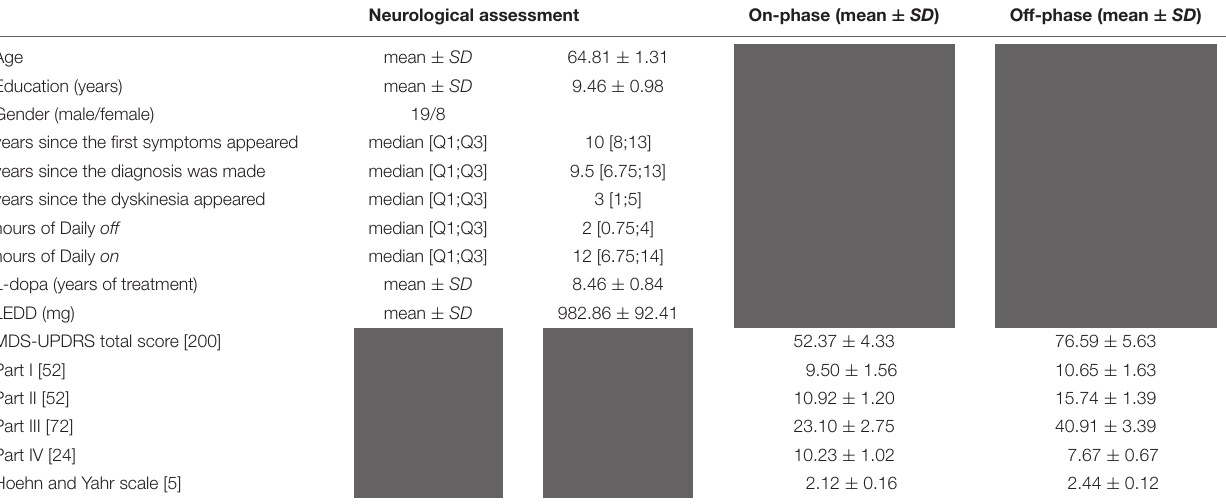
Table 1 . More information regarding the experimental sample